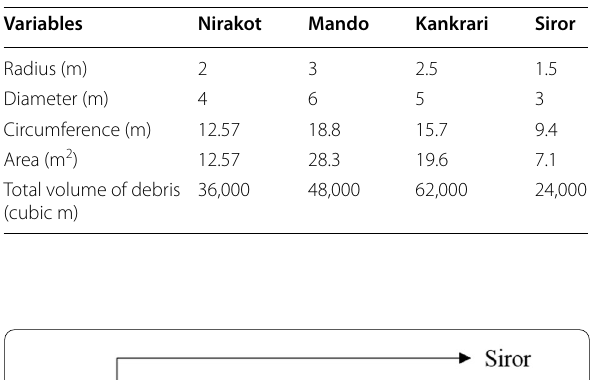
Table 5 Average circumference, area, and volume of boulders.